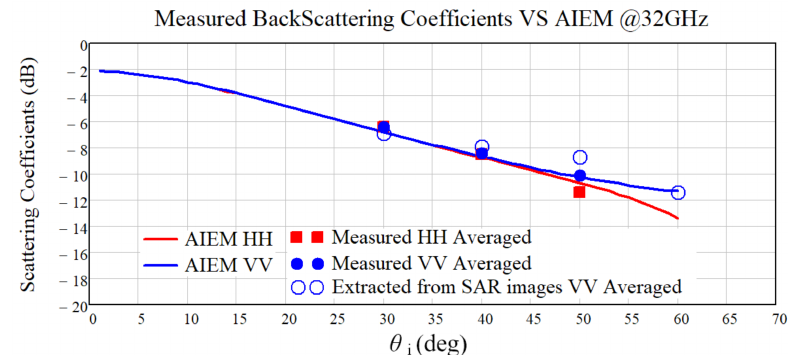
Figure 6. Comparison between measured scattering coefficients ( σ 0 ) of the exponentially correlated rough surface sample and the results by AIEM prediction, at 32 GHz. (The image extracted σ 0 are from the image results of 60 mm resolution cell size and are also listed in Table 4).